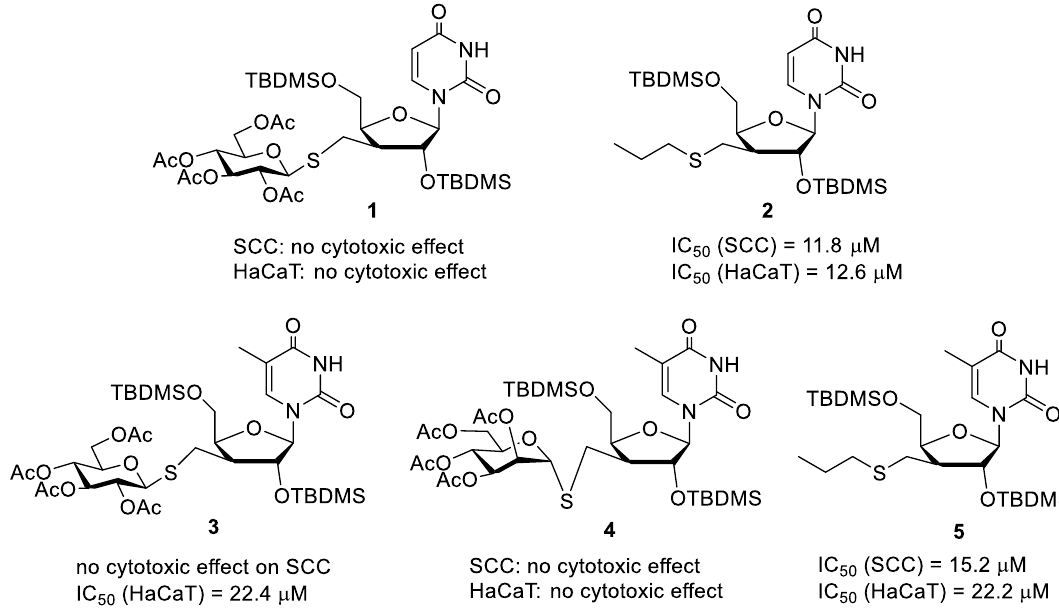
Figure 2. Cytotoxic e ff ects of the previously prepared 3’-deoxy-3’-C-modified β - d -xylofuranosyl-uracil ( 1 and 2 ) and –thymine ( 3–5 ) derivatives [19] on squamous cell carcinoma (SCC) and human keratinocyte (HaCaT) cell lines. (TBDMS: tert